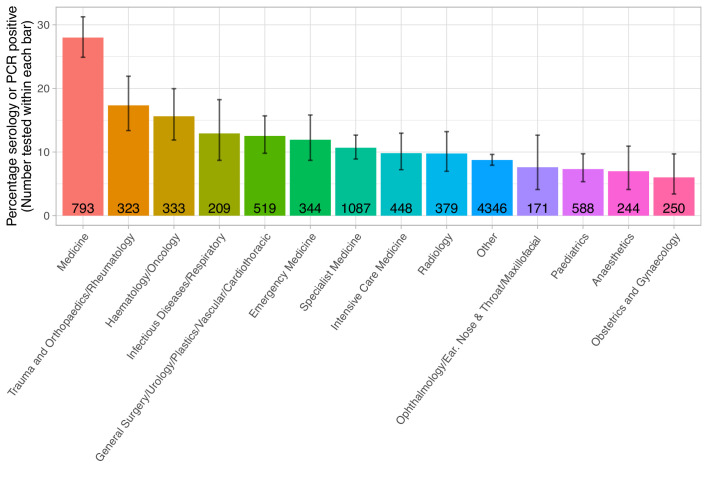
Proportion of staff testing positive by specialty area.The number of staff tested within each speciality is shown within each bar. The error bar indicates the 95% confidence interval. The ‘Other’ group includes staff members without a self-reported specialty. Staff working in a specialty area are predominantly nurses, healthcare assistances, doctors and therapists.